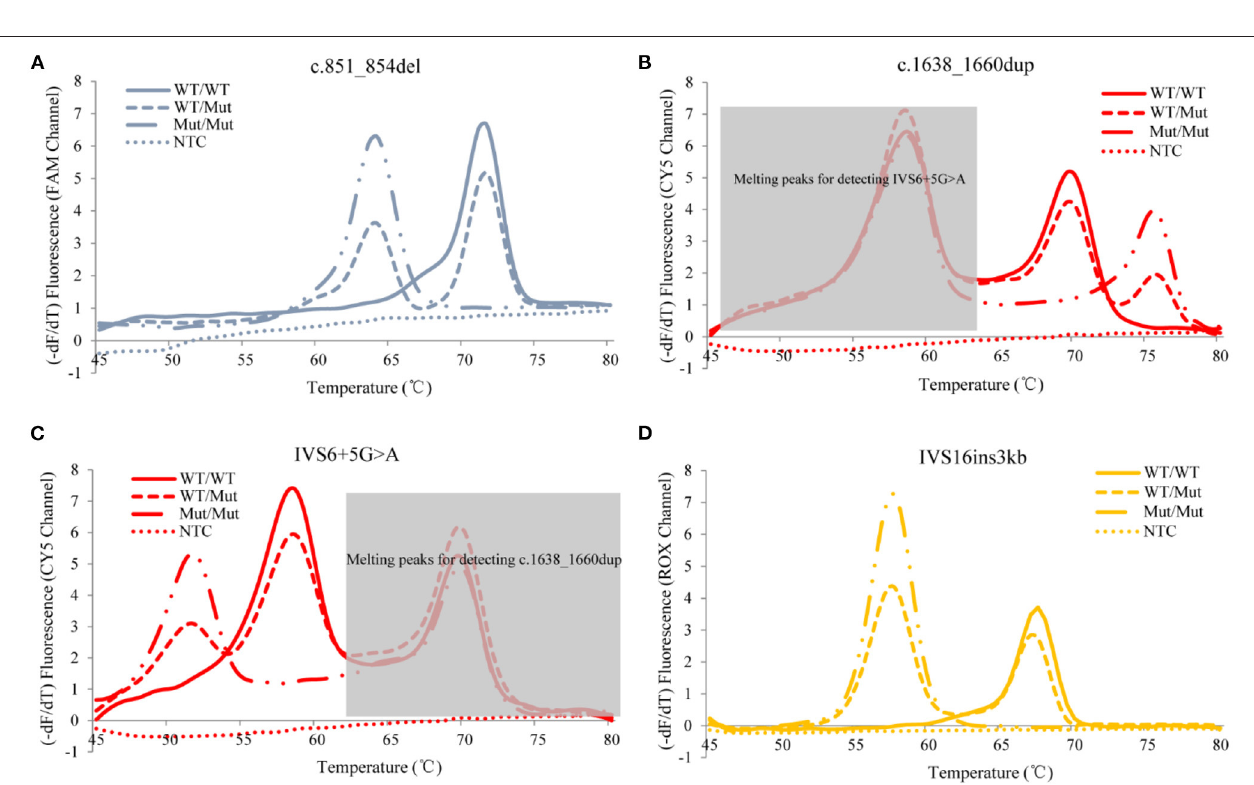
FIGURE 2 | Representative genotyping results of the four prevalent SLC25A13 mutations using the MMCA assay. Melting curves and fluorescence melting peaks, as well as corresponding genotypes, are provided according to the detection mutations above the panel [ (A) c.851_854del; (B) c.1638_1660dup; (C) IVS6 + 5G > A; (D) IVS16ins3kb]. In each panel, melting curves are displayed in only one channel that is related to the detection mutation, and marked on the y-axis. The mutations are individually identified by their labeling fluorophores and Tm values, and all mutant alleles generate distinct melting peaks corresponding to the wild-type alleles. –dF/dT, the negative derivative of fluorescence over temperature; WT, wild-type; Mut, mutant; NTC, no DNA template control; MMCA, multicolor melting curve analysis.